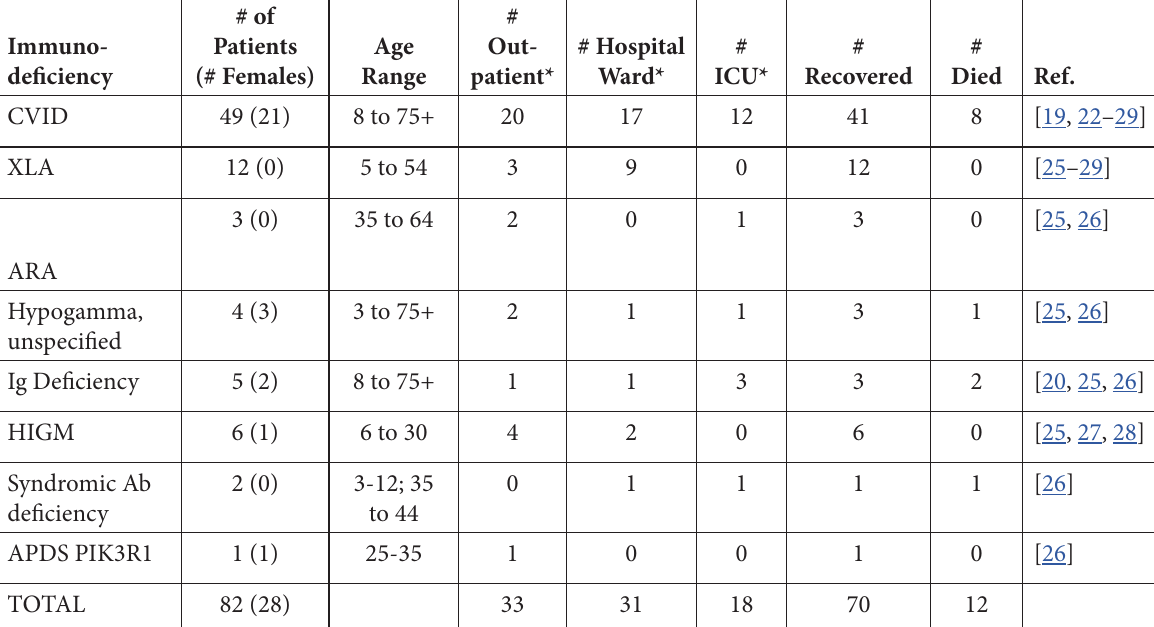
Table 4: Clinical Outcomes in Patients with hIEI and with Confirmed COVID-19 Immuno- deficiency